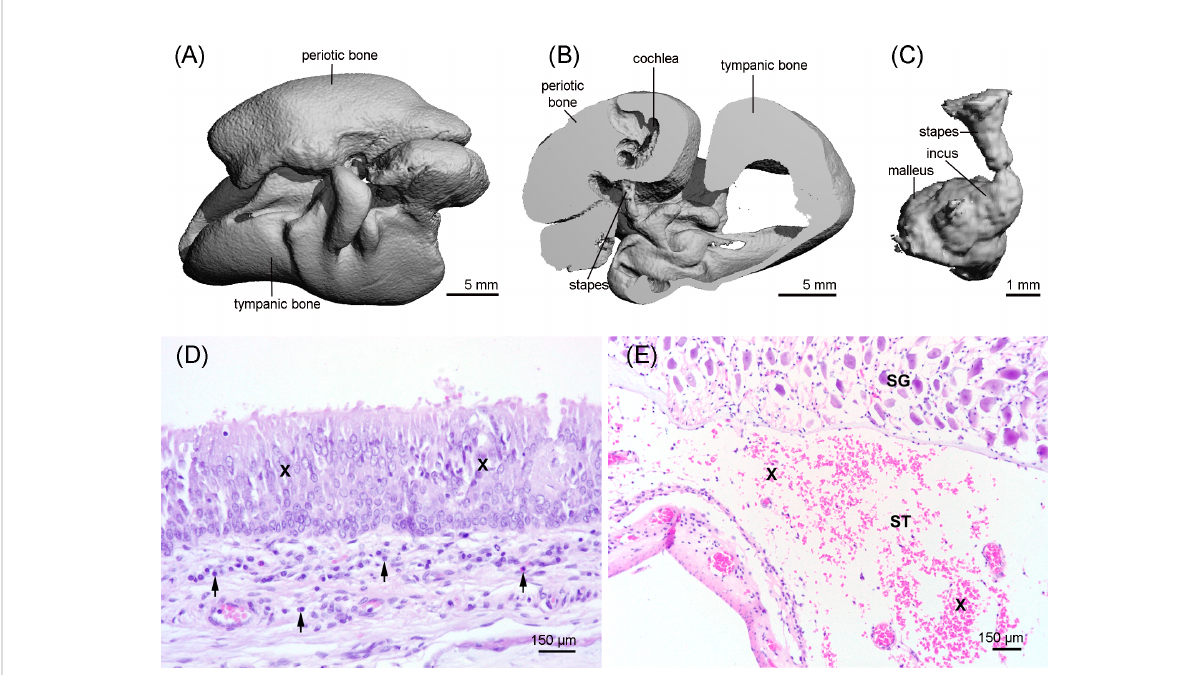
FIGURE 7 3D reconstruction of the tympano-periotic complex (A, B) and the middle ear ossicles (C) showing an apparent normal morphology. (D) Middle ear with moderate-to-marked epithelial hyperplasia (X) and diffuse mild subepithelial in fl ammation (arrows), hematoxylin and eosin stain. (E) Moderate acute hemorrhage (X) in the scala tympani (ST); SG: spiral ganglion cells; hematoxylin and eosin